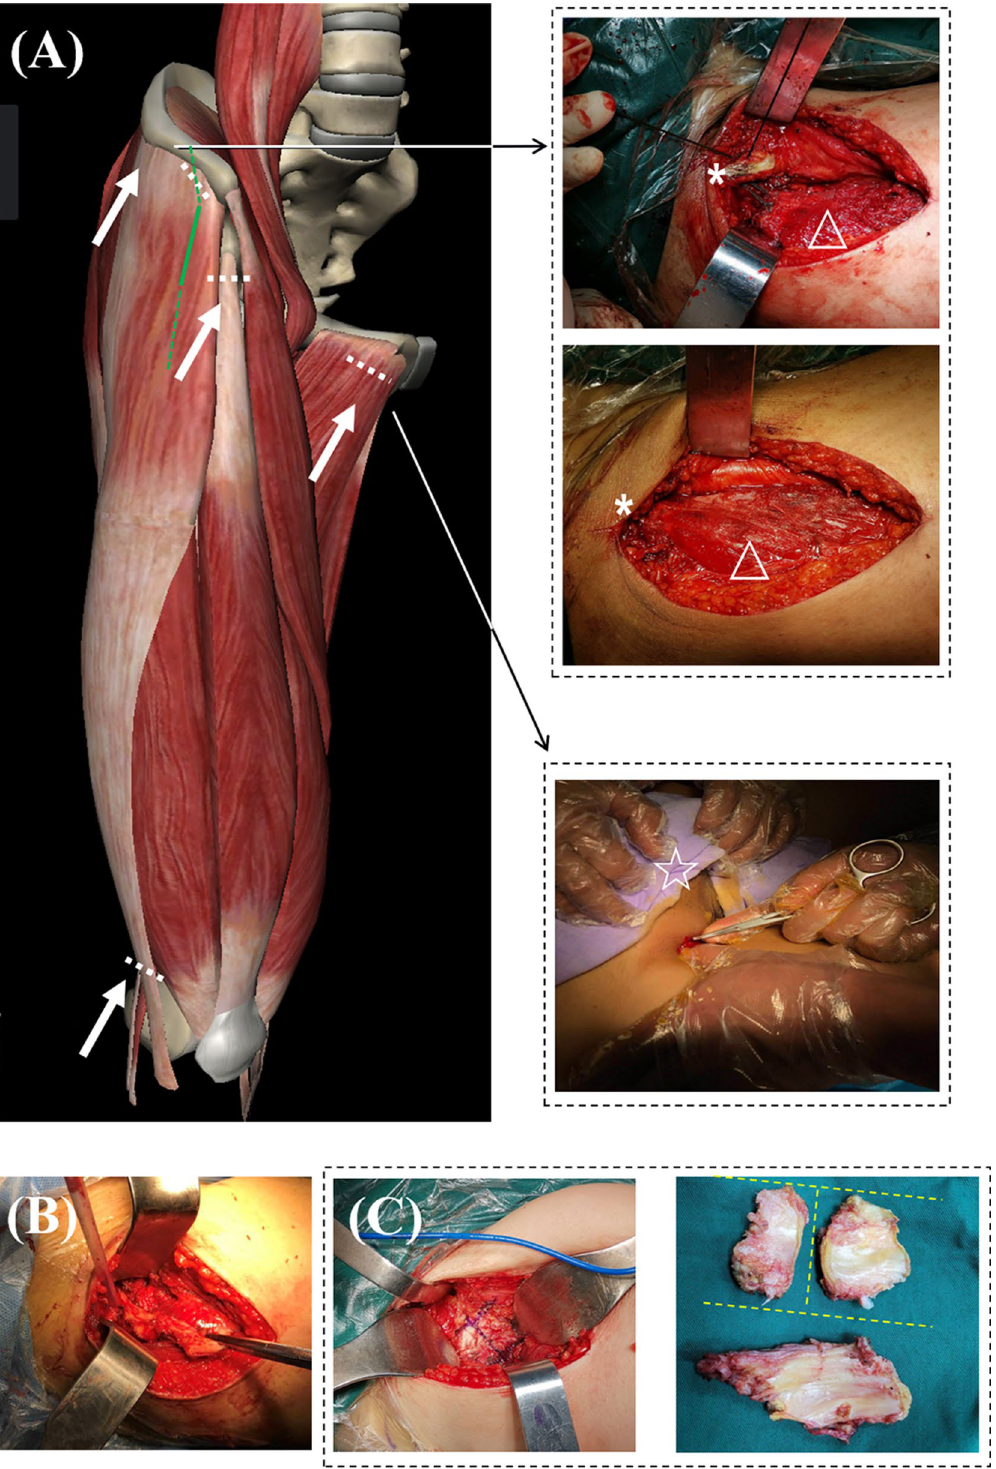
Figure 2. Soft tissue balancing techniques for Crowe III-IV DDH in DAA THA. ( A ) Common structures for soft tissue release include the tensor fascia latae (TFL), adductor tendon, rectus femoris, and distal iliotibial band (white arrows). A standard DAA (full green line) can be converted into an extensile DAA (dotted green line) when further extension was required. The upper right represents peel-off technique of TFL at the iliac attachment and repair technique using non-absorbable sutures (* anterior superior iliac spine, ∆ TFL belly.) The middle right represents pie-crusting technique of the adduction tendon ( ☆ symphysis pubis). ( B ) Resection of whole capsule in a sleeve-like en-bloc capsulectomy technique. ( C ) Anterior capsule resection in a H-shape manner after the Hueter interval is fully obtained. Resected anterior and posterior